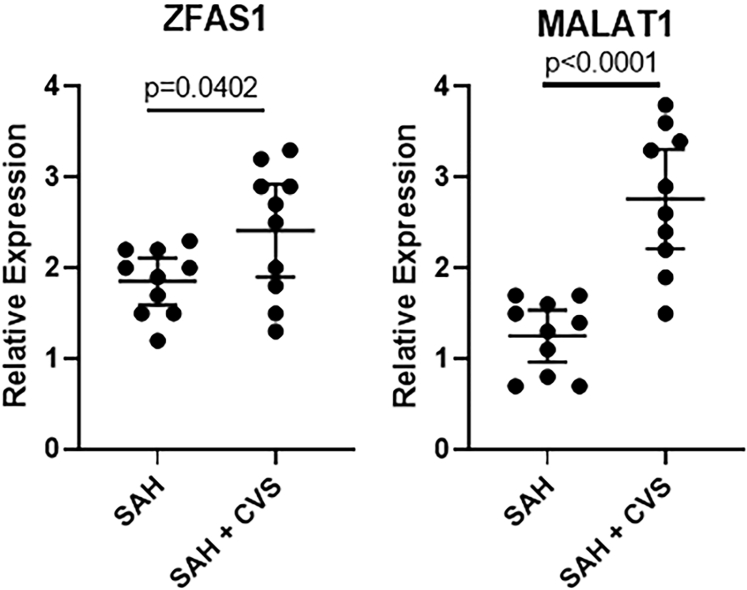
lncRNAs ZFAS1 and MALAT1 in SAH PatientsExpression levels of lncRNAs ZFAS1 and MALAT1 in pooled samples representing patients with SAH (without CVS) and those with SAH and CVS. Values plotted are mean ± 95% confidence interval (CI).